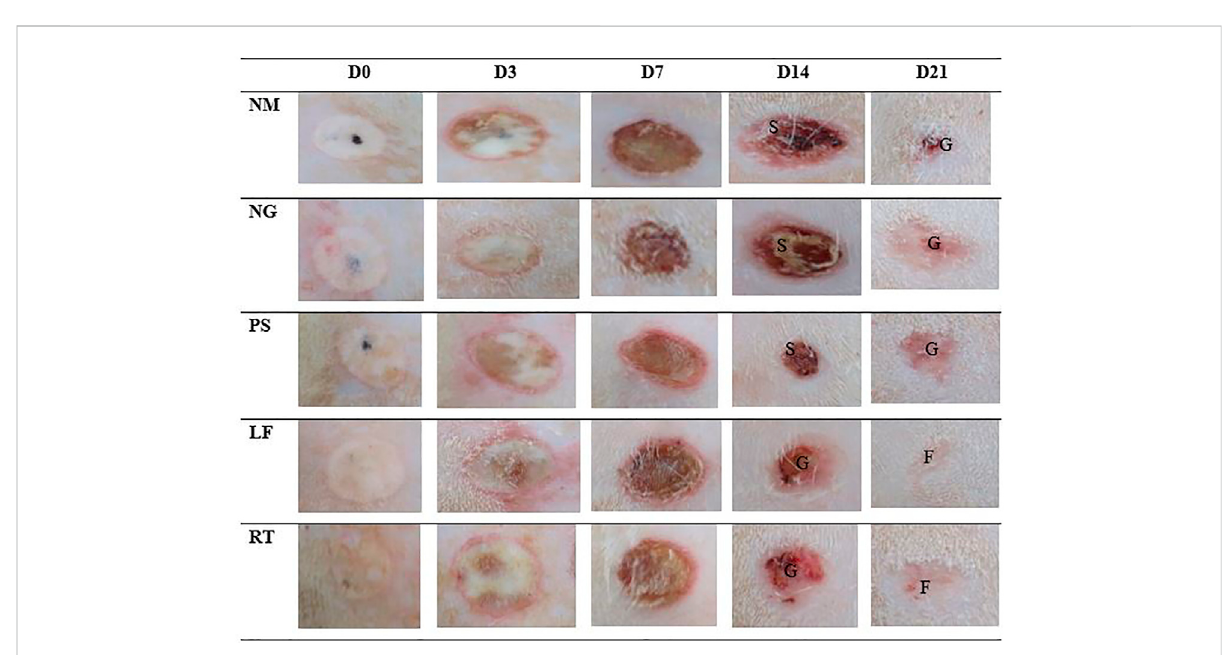
FIGURE 3 Macroscopic view of fi verepresentativemale ratsfrom eachgroup atday0,3, 7,14 and21.S: Scab;G: Granulation tissue; F:Fibroustissue. NM: normal control group, NG: negative control group, PS: positive control group, LF: LPVa leaf-treated group, RT: LPVa root-treated